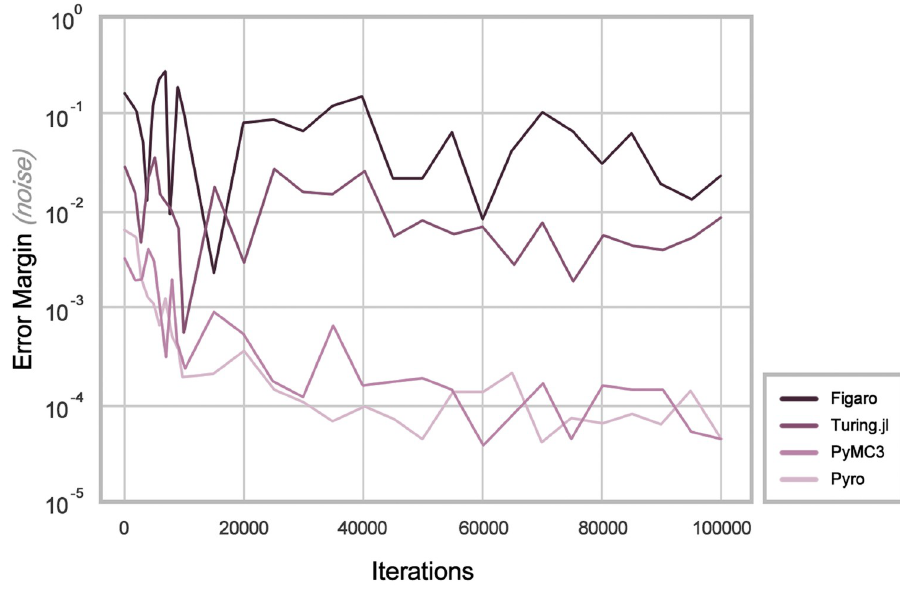
Fig 7. Accuracy Of EPR